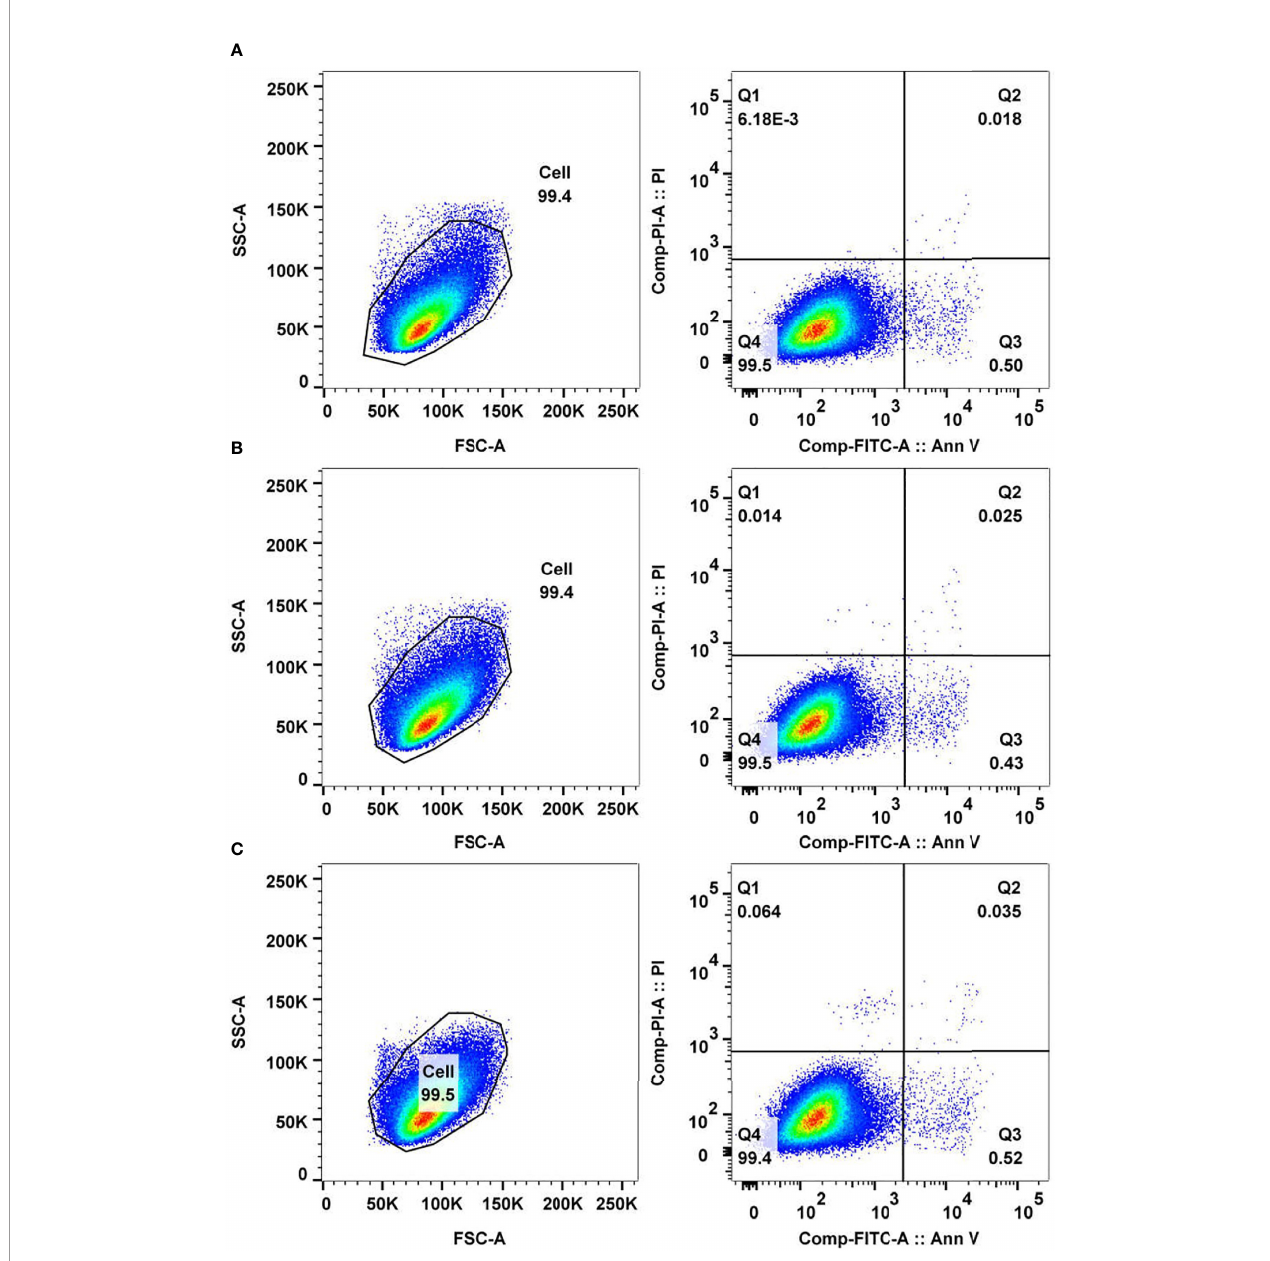
FIGURE 7 | Analysis of cancer cell apoptosis and necrosis mediated by antitumor peptide 2. HepG2 cells (5 × 10 5 cells) were treated with 337 µgmL -1 of antitumor peptide 2, 1% DMSO (diluent control), and medium alone (negative control) for 24 h. Cells of all treatments were stained with fl uorochrome-conjugated Annexin V and propidium iodide (PI) and analyzed by fl ow cytometry. (A) FACS analyses of Annexin V- and PI-stained HepG2 cells treated with antitumor peptide 2. (B) FACS analyses of Annexin V- and PI-stained HepG2 cells treated with 1% DMSO. (C) FACS analyses of Annexin V- and PI-stained HepG2 cells treated with medium alone. Lower right quadrant (Q3) Annexin V-positive/PI-negative cells denote early apoptotic cells, and upper right quadrant (Q2) Annexin V-positive/PI-positive cells denote necrotic or late apoptotic